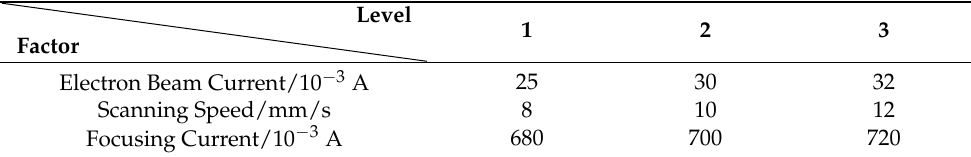
Table 3. The cladding process parameter’s factor level